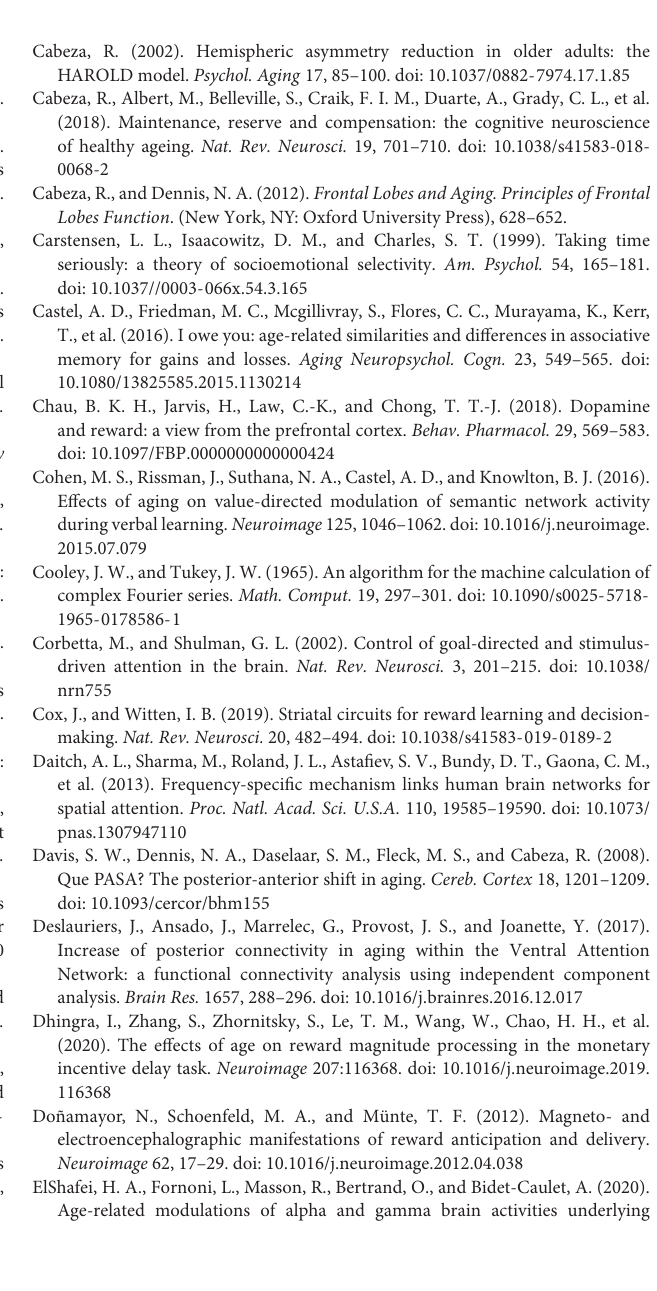
Supplementary Figure 1 | Pearson’s partial correlation analysis, based on single mean values of the participants, for all three RT differences versus age, controlling for the non-participating reward condition in the difference (left: 3–30 cent, controling for 0 cent, middle: 0–30 cent, controlling for 3 cent, right: 0–3 cent, controlling for 30 cent), no significant effect could be found. Supplementary Figure 2 | Analysis of interregional analysis within the young group for the reward vs neutral cue. (A) Corrplot with FDR-corrected p -values for the alpha band; (B) Corrplot with FDR-corrected p -values for the delta